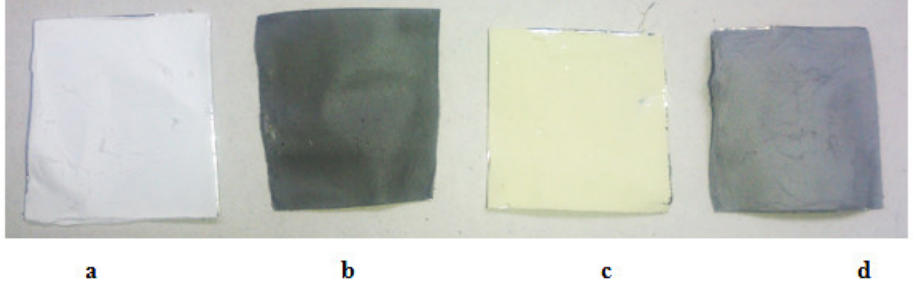
Figure 5. Optical images of electrospun nanofiber mats: ( a ) PAN; ( b ) PAN/MWCNT; ( c ) PAN/MOF; ( d ) PAN/MWCNT/MOF.